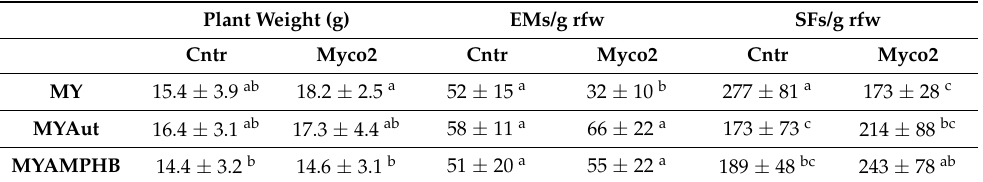
Table 1. Plant growth and nematode infection factors of tomato plants treated with (i) sterile distilled water (Cntr) and Myco2 suspensions (MY); (ii) autoclaved distilled water and Myco2 suspensions MYAut; (iii) sterile distilled water and Myco2 suspensions added with 100 µ g mL − 1 amphotericin B (MYAMPHB). Plants were inoculated with RKN J2s and harvested after 60 days. Plant growth was evaluated by plant weight (g); nematode infection by the numbers of egg masses (EMs) and sedentary forms (SFs) per gram of root fresh weight (g rfw). Values are expressed as mean ( n = 12) ± SD; means of each parameter were separated by Duncan’s test, different letters indicate significantly different means (significance level: 0.05). Plant Weight (g) EMs/g rfw SFs/g